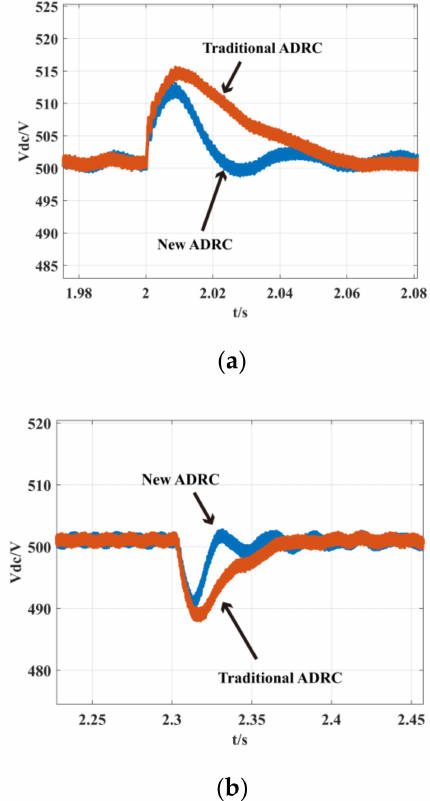
Figure 16. Comparison of simulation graphs of two control strategies under grid load and load reduction conditions. ( a ) Comparison of control e ff ects under grid load conditions; ( b ) Comparison of control e ff ects under grid load reduction